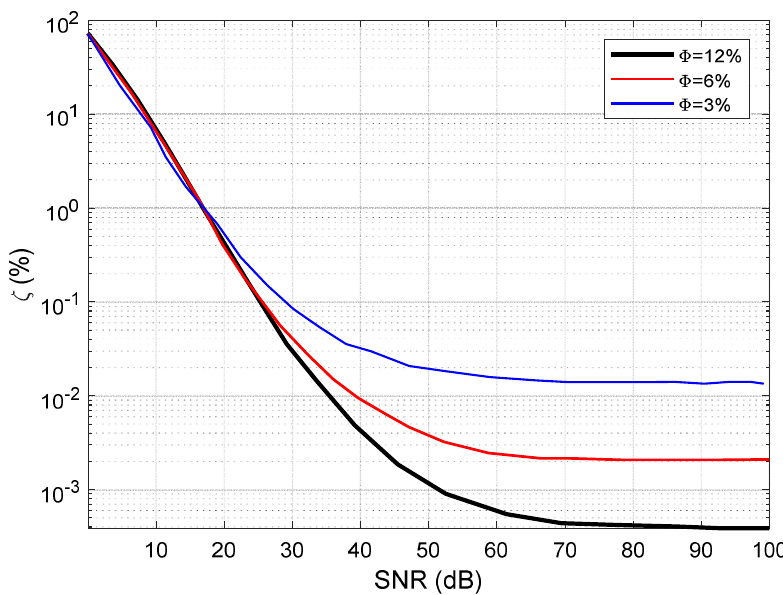
Figure 6. Detection index against signal-to-noise ratio (SNR) for different failure percentages.